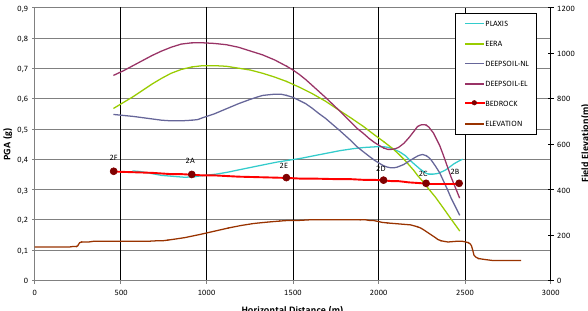
Figure 11. Change in the peak ground acceleration on the surface for 2-2’ section.